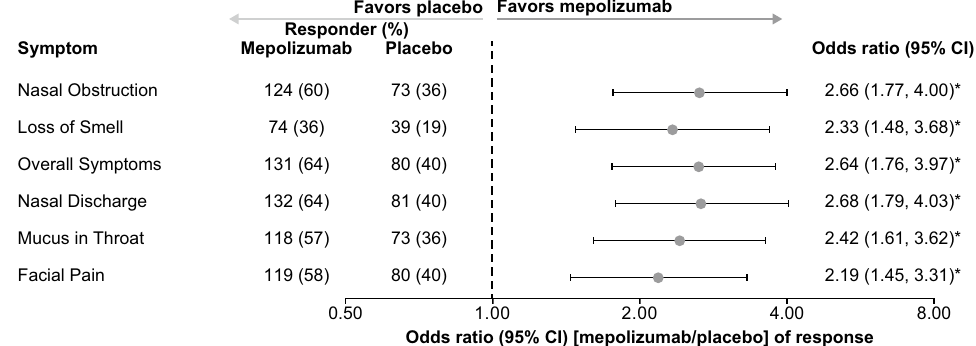
2.5-point change (improvement) for overall ≥